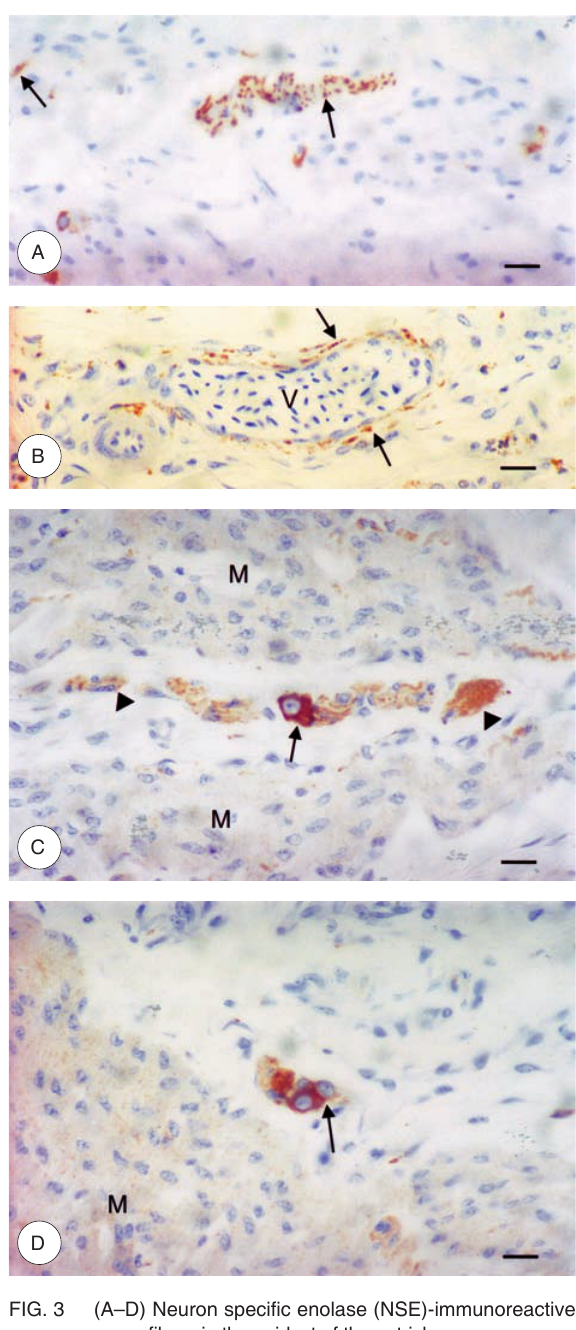
FIG. 3 (A–D) Neuron specific enolase (NSE)-immunoreactive nerve fibres in the oviduct of the ostrich (A) NSE-immunoreactive nerve fibres (arrow) in the lamina propria-submucosa of the isthmus. (B) NSE-im- munoreactive nerve fibres (arrows) distributed in the wall of a blood vessel (V) in the intermuscular connec- tive tissue area of the shell gland. (C) A NSE-immuno- reactive nerve cell body (arrow) is observed in a nerve bundle (arrowheads). M: smooth muscle cells. (D) Nerve cell bodies (arrow) with NSE-immunoreactive cytoplasm are observed in the intermuscular connective tissue area of the vagina. M: smooth muscle Scale bar = 50 μ